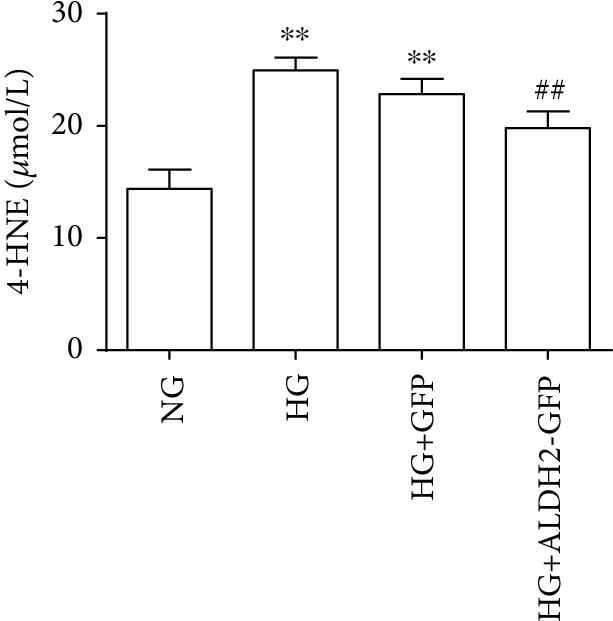
The level of 4-HNE after high glucose intervention (mean ± SD, n = 5). ∗∗P < 0.01vs. NG; ##P < 0.01vs. HG and HG+GFP.